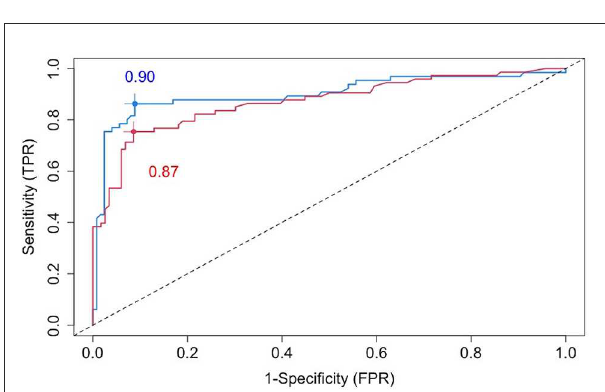
FIGURE3 Cross-validated ROC curves for estimated failure probabilities based on all baseline covariates (blue line) or the five most prognostic variables (i.e., the top five variables ranked by the variable importance from random forests): age, SBP, AST, BMI, and CRP (red line).